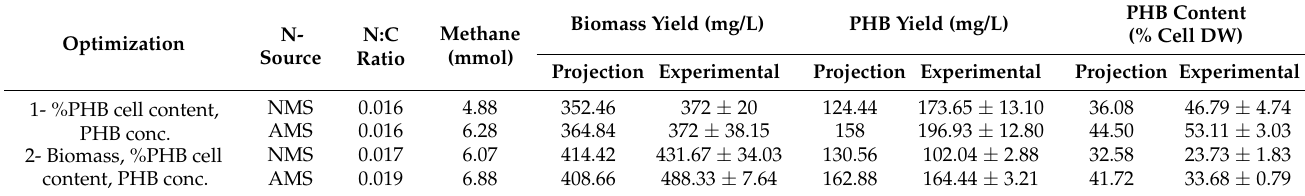
Table 3. Prediction and experimental validation of multi-objective optimal conditions. Based on the complete set of RSM experimental responses, the multi-objective optimal condition was predicted for NMS and AMS by Design Expert ® version-11 software. Optimization #1 was intended to yield maximum %PHB cell content (on the basis of cell dry weight, DW) and PHB concentration, whereas Optimization set #2 was intended to yield maximum biomass, %PHB cell content, and PHB concen- tration. The projected amount of methane (mmol) and N:C ratios were then tested experimentally for comparison. Standard deviations for n = 3 replicates are